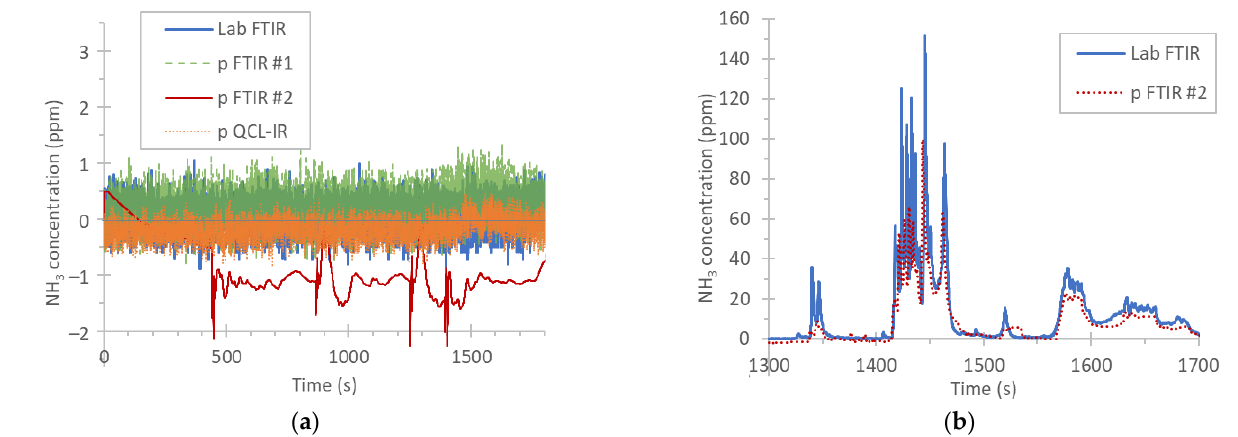
Figure 7. Real time NH 3 concentrations: ( a ) hot start WHTC with the diesel engine D1; ( b ) part of a WHTC with the CNG engine. CNG = compressed natural gas engine; FTIR = Fourier transform infrared; p = portable; PEMS = portable emissions measurement system; QCL-IR = quantum cascade laser infrared; WHTC = world harmonized transient cycle.